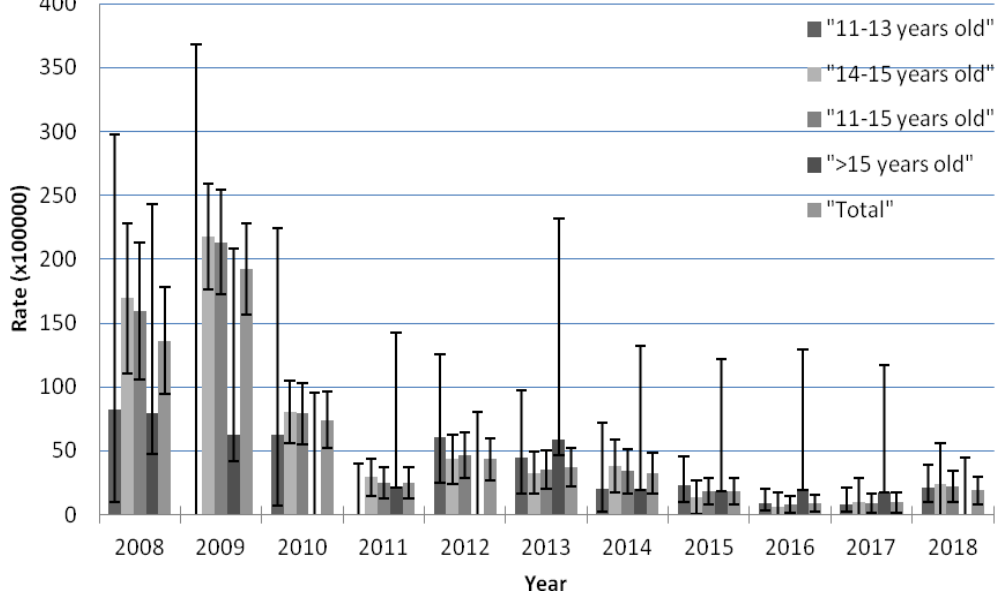
Figure 1. AEFI reporting rates per 100,000 by age group in the Valencian Community, Spain (2008–2018).